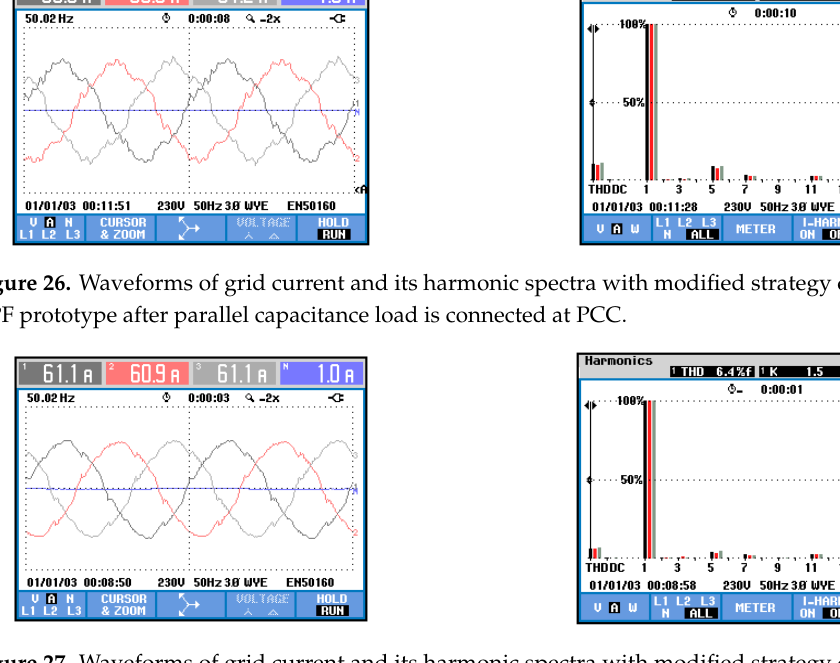
Figure 27. Waveforms of grid current and its harmonic spectra with modified strategy control shunt APF prototype carrying active load and three-phase rectifier load.